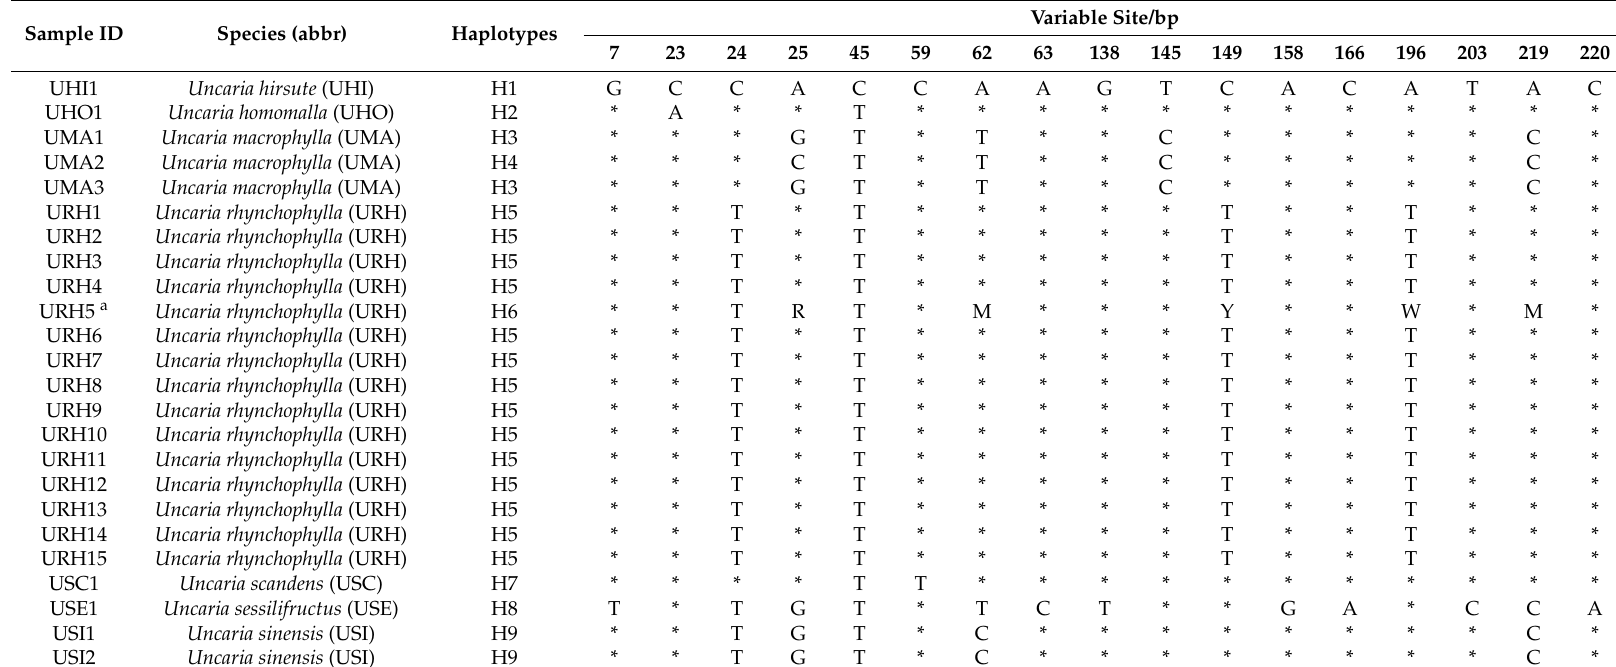
Table 1. The interspecific variable sites in the ITS2 sequences of Uncaria